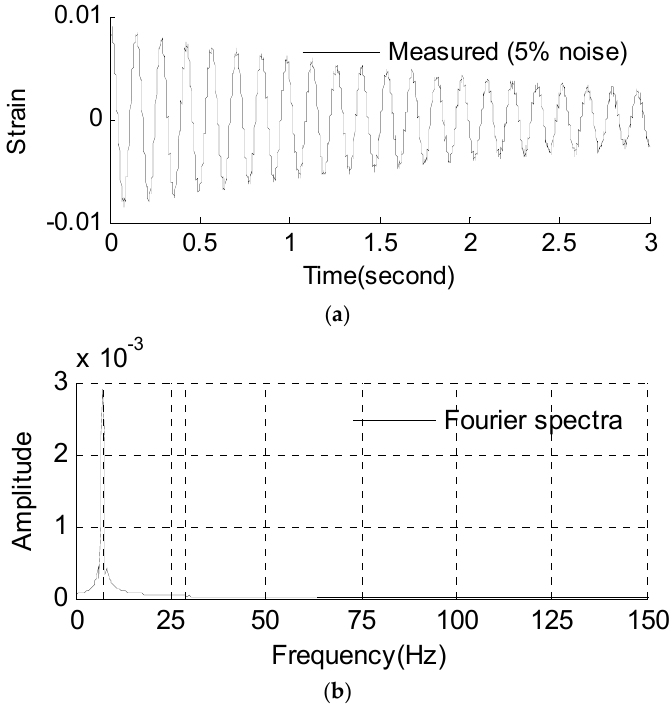
Figure 9. Strain gauge measurement data and Fourier spectra of the data. ( a ) Strain gauge measurement data (0–3 s); and ( b ) Fourier spectra of the measurement data (0–3 s).